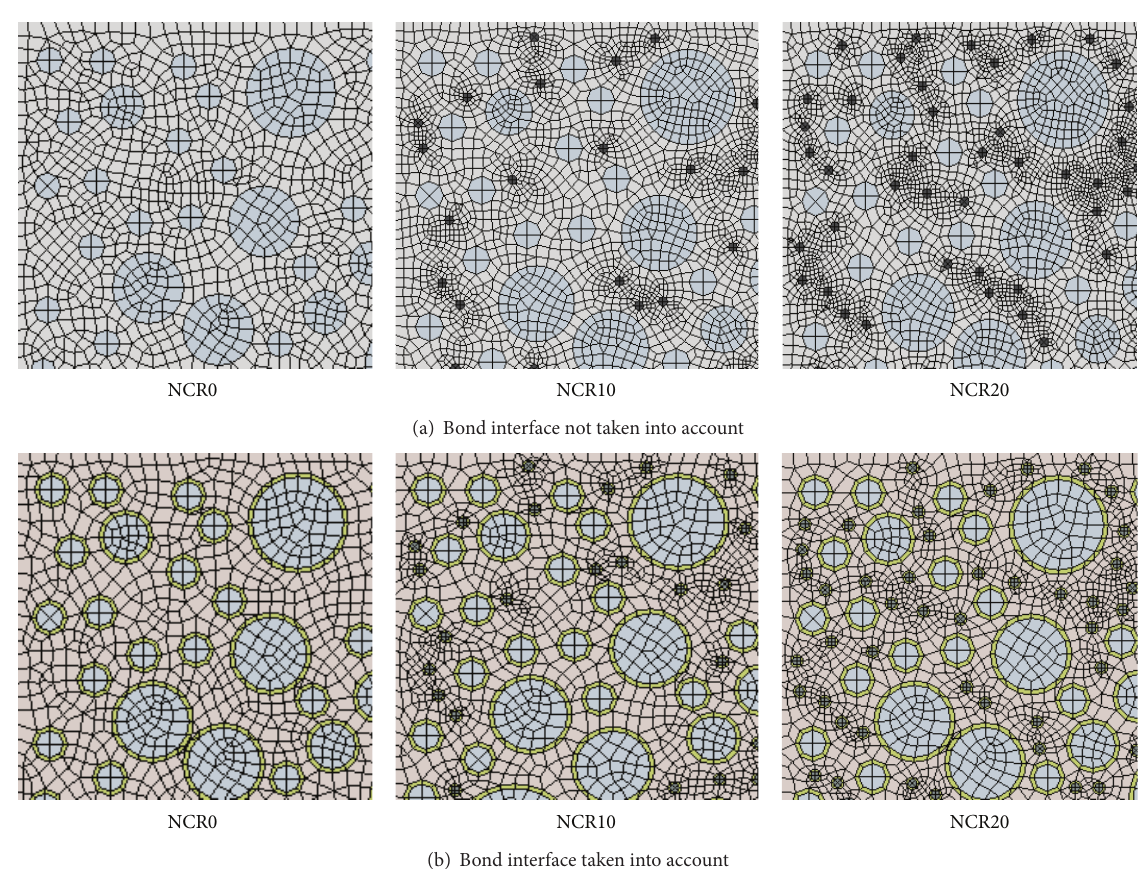
Figure 5: Enlarged finite-element meshes of various rubber